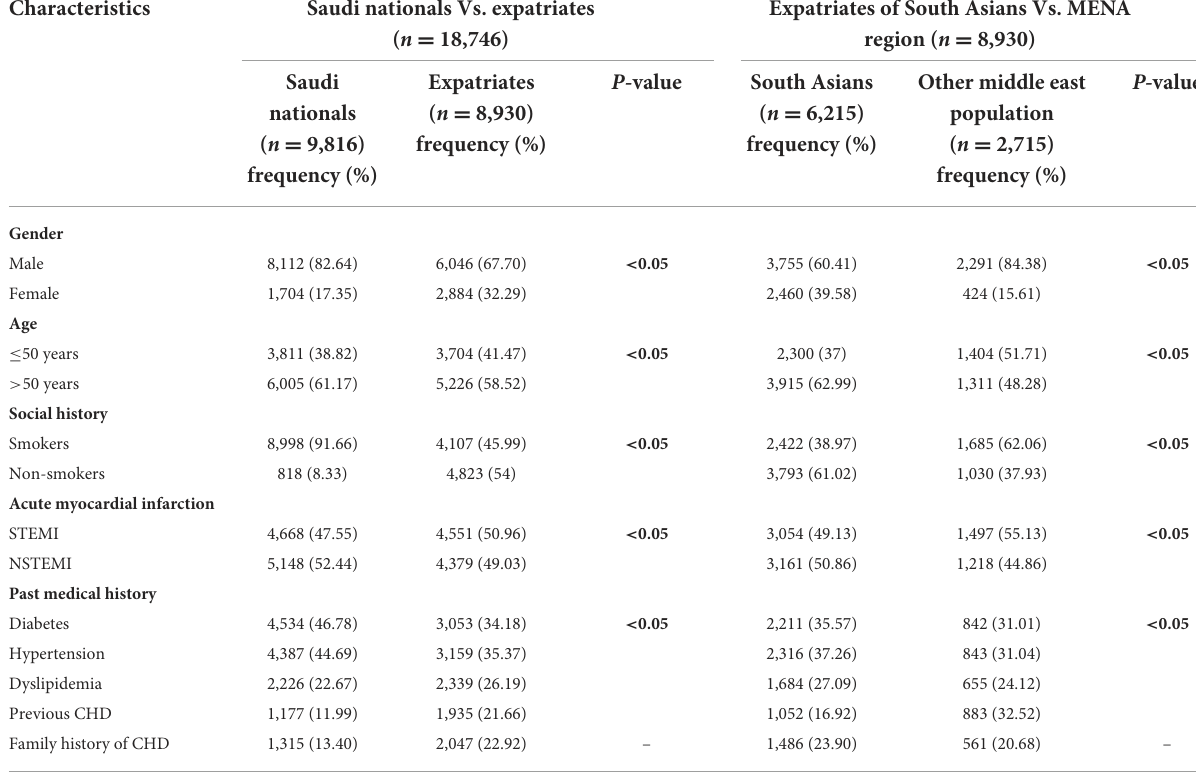
TABLE 4 The association between demographic parameters of ethnicity and risk factors in the studied population diagnosed with AMI.